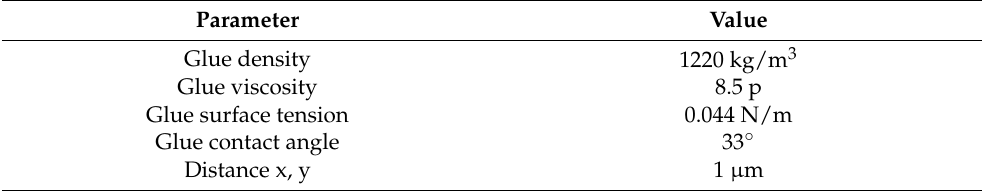
Figure 6. Simulation model and simulation results: ( a ) simulation model; ( b ) simulation results for the condition of 0 hPa. Table 1. Parameter of simulation model. Table 1. Parameter of simulation